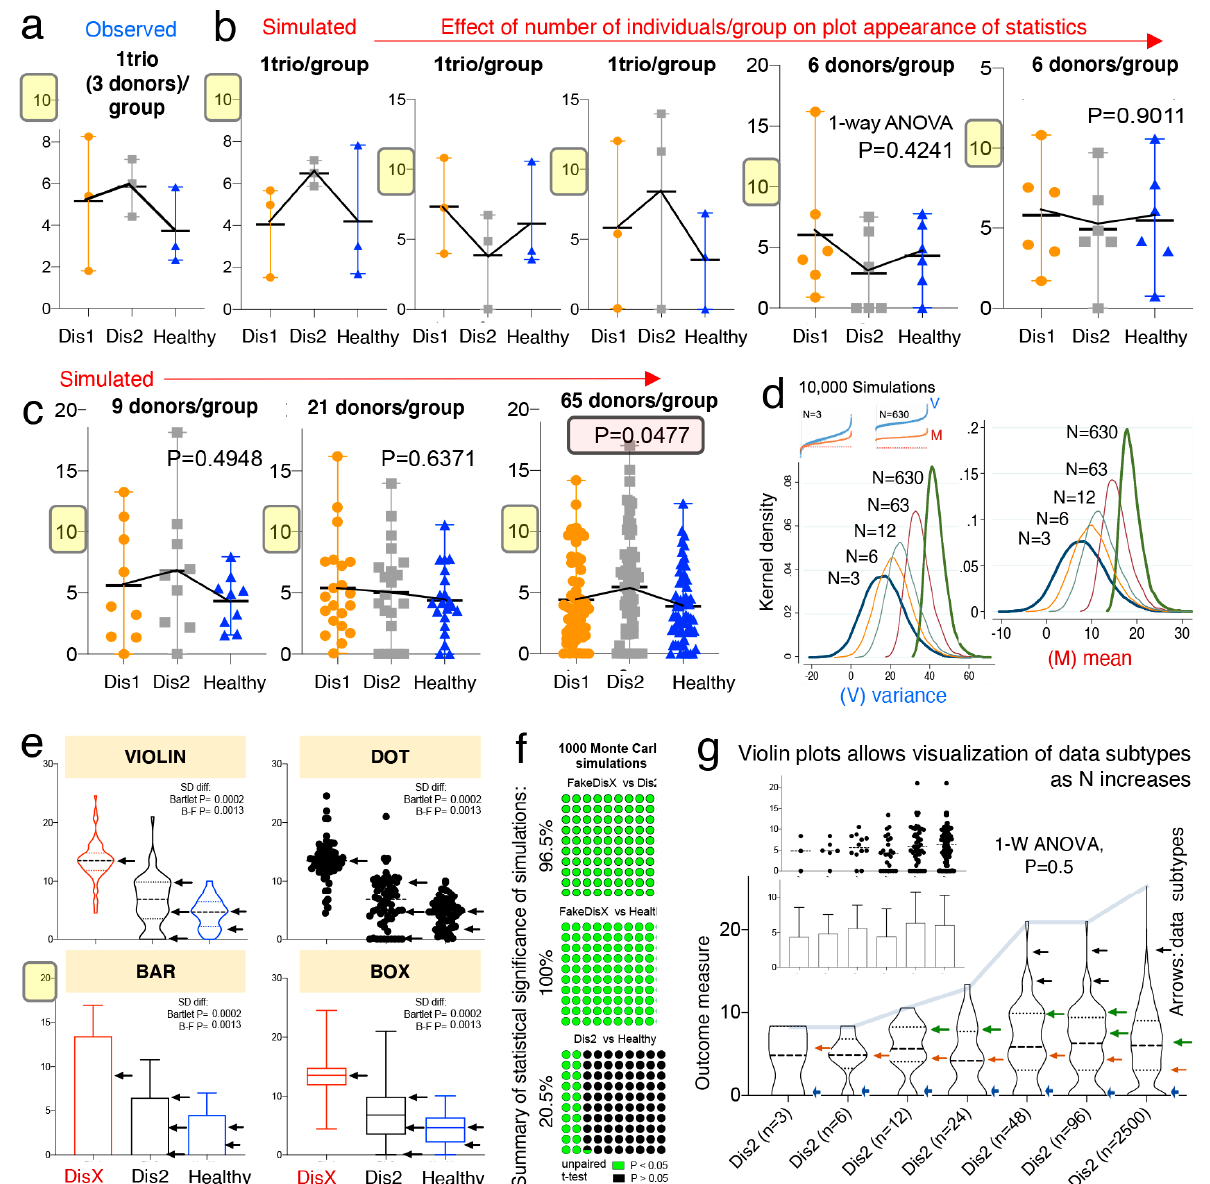
Figure 2. Violin plots enable visualization of data subtypes in simulations of random sampling for various N sample size. Observed raw data derived from Basson et al. ( a,b ) Dot plots (mean, range) of observed (1 “trio”; 3 donors/group), and simulated data (3 and 6 donors/group; panel B). Note that differences are not significant because of the variability between diseases. ( c ) Dot plots (mean, range) of simulated data for 9, 21, and 65 donors per group. Note that simulated mean effects became significant with 65 donors/group. However, the mean difference is small compared to the variance of the groups and the difference is not biologically different because it is a function of the total variance (23%). ( d ) Kernel density simu- lations (10,000) based on observed (n = 3) and simulated data. Note that as N increases the mean becomes narrower while the variance widens. See 100,000 Monte Carlo simulations in Supplementary Table S1. ( e ) Comparison of visual appear- ance and data display for violin, dot, bar, and box plots of simulated data to illustrate “disease data subtypes” (arrows). ( f ) Plot illustrates cumulative proportion of simulation runs that generated a significant (green, p < 0.05) or nonsignificant value (black, p > 0.05). Analysis illustrates how Monte Carlo adjusted analysis could be reported with observed findings. See Supplementary Figure S4 for 100,000 Monte Carlo simulations of random numbers generated in R. ( g ) Violin plots allow visualization of data subtypes as N increases (arrows, subtypes).